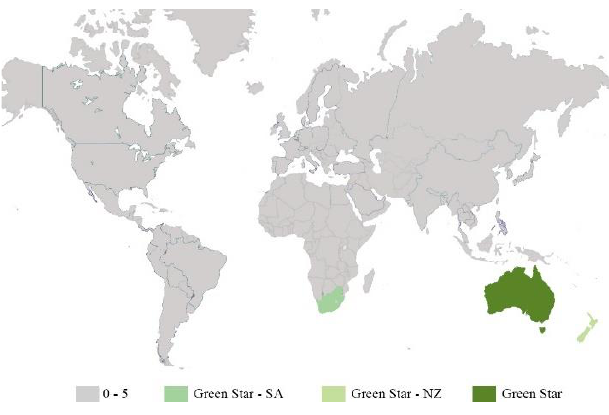
Fig. 4. Countries with Green Star certificates in the world and the number range [Created by the authors based on Green Star data]